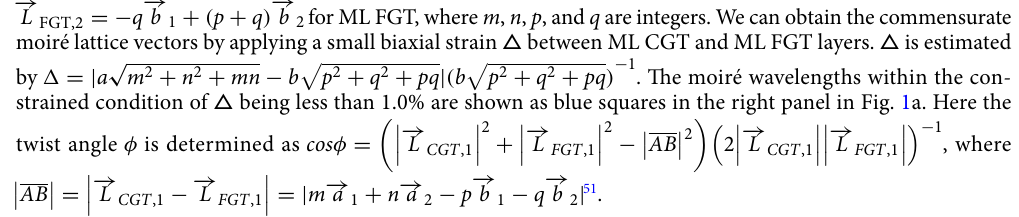
1 ( b a √ m 2 n 2 mn b p 2 q 2 pq p 2 q 2 pq ) − . The moiré wavelengths within the con- by � = | + + − + + | + + strained condition of △ being less than 1.0% are shown as blue squares in the right panel in Fig. 1a. Here the (cid:31) (cid:31) twist angle φ is determined as cos φ = (cid:31)(cid:30) Figure 1b displays the top and side views of the moiré superlattice with λ = 25.02 Å, △ = 0.55%, φ = 11.39°, ( m , n , p , q ) = (1, 3, 3, 4), and the total number of atoms being 352. Only Fe1, Te FGT , Te CGT , Ge CGT , and Cr atoms near the interface are depicted in the top view of Fig. 1b. The moiré supercell has CrTe 6 hexagonal networks on top of FGT and various stacked structures. The in-plane and out-of-plane distortions obtained by the spin-polarized optB88 vdW method are displayed in Fig. 1c,d, respectively. The in-plane displacement vectors indicated by red arrows show more in-plane distortion in CGT than in FGT and are largest at the Te CGT layer. In particular, the in-plane displacement vectors of all Te CGT atoms have consistent patterns regardless of stacking, as depicted by black circles, but those of other atoms vary depending on stacking. The z -coordinates of Te CGT and Te FGT atoms inside the green shaded region in (b) vary depending on stacking, as shown in Fig. 1d. The out-of-plane distor- tion of the Te CGT layer is much larger than that of the Te FGT layer. The variation of interlayer distance between two interface Te layers is largest in the area where Te CGT atoms are closely located above Te FGT atoms. The unfolded band structures of the moiré heterobilayer with a twist angle of 11.39° reveal some distinct features compared with the unit-cell band structures of a single layer, as shown in Fig. 1e. All the band structures were obtained using the noncollinear PBE + U + SOC method when U = 3.5 eV and J = 1.0 eV for Cr 3 d orbitals, and an FM spin alignment between FGT and CGT was considered. The average magnetic moment is 3.64 µ B / atom for Cr, 2.61 µ B /atom for Fe1, and 1.65 µ B /atom for Fe2. The unfolded band structures of FGT (HB FGT) near the Fermi level are similar to the unit-cell band structures of ML FGT except for bands shifted higher in